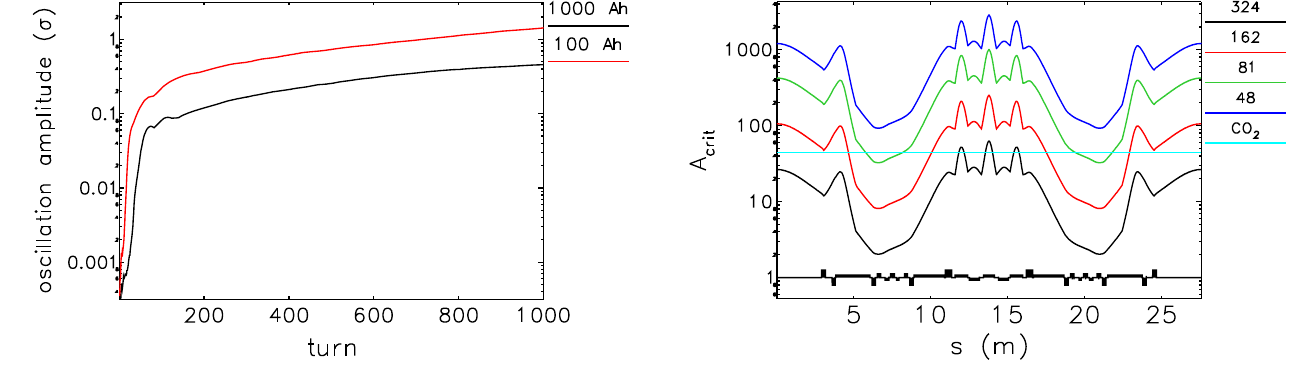
FIG. 9. Ion instability amplitude (in units of vertical beam size) for 324 bunches, 200 mA, comparing 100 Ah and 1000 Ah conditioning.